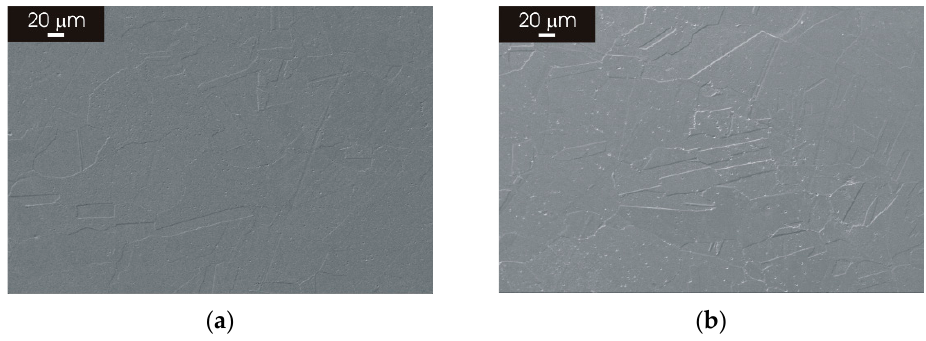
Figure 10. SEM micrographs of L-PBF-XZ 316L stainless steel heat treated at 1100 °C ( a ) heat treatment for 8 h; ( b ) heat treatment for 24 h.